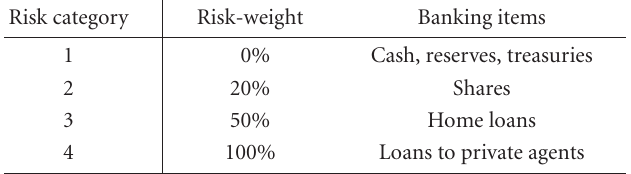
Table 2.1. Risk categories, risk-weights, and representative